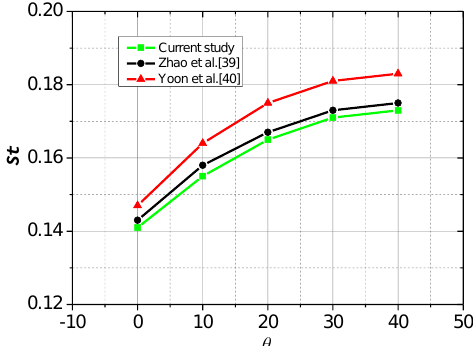
Figure 2. Simulated results compared with previous results.